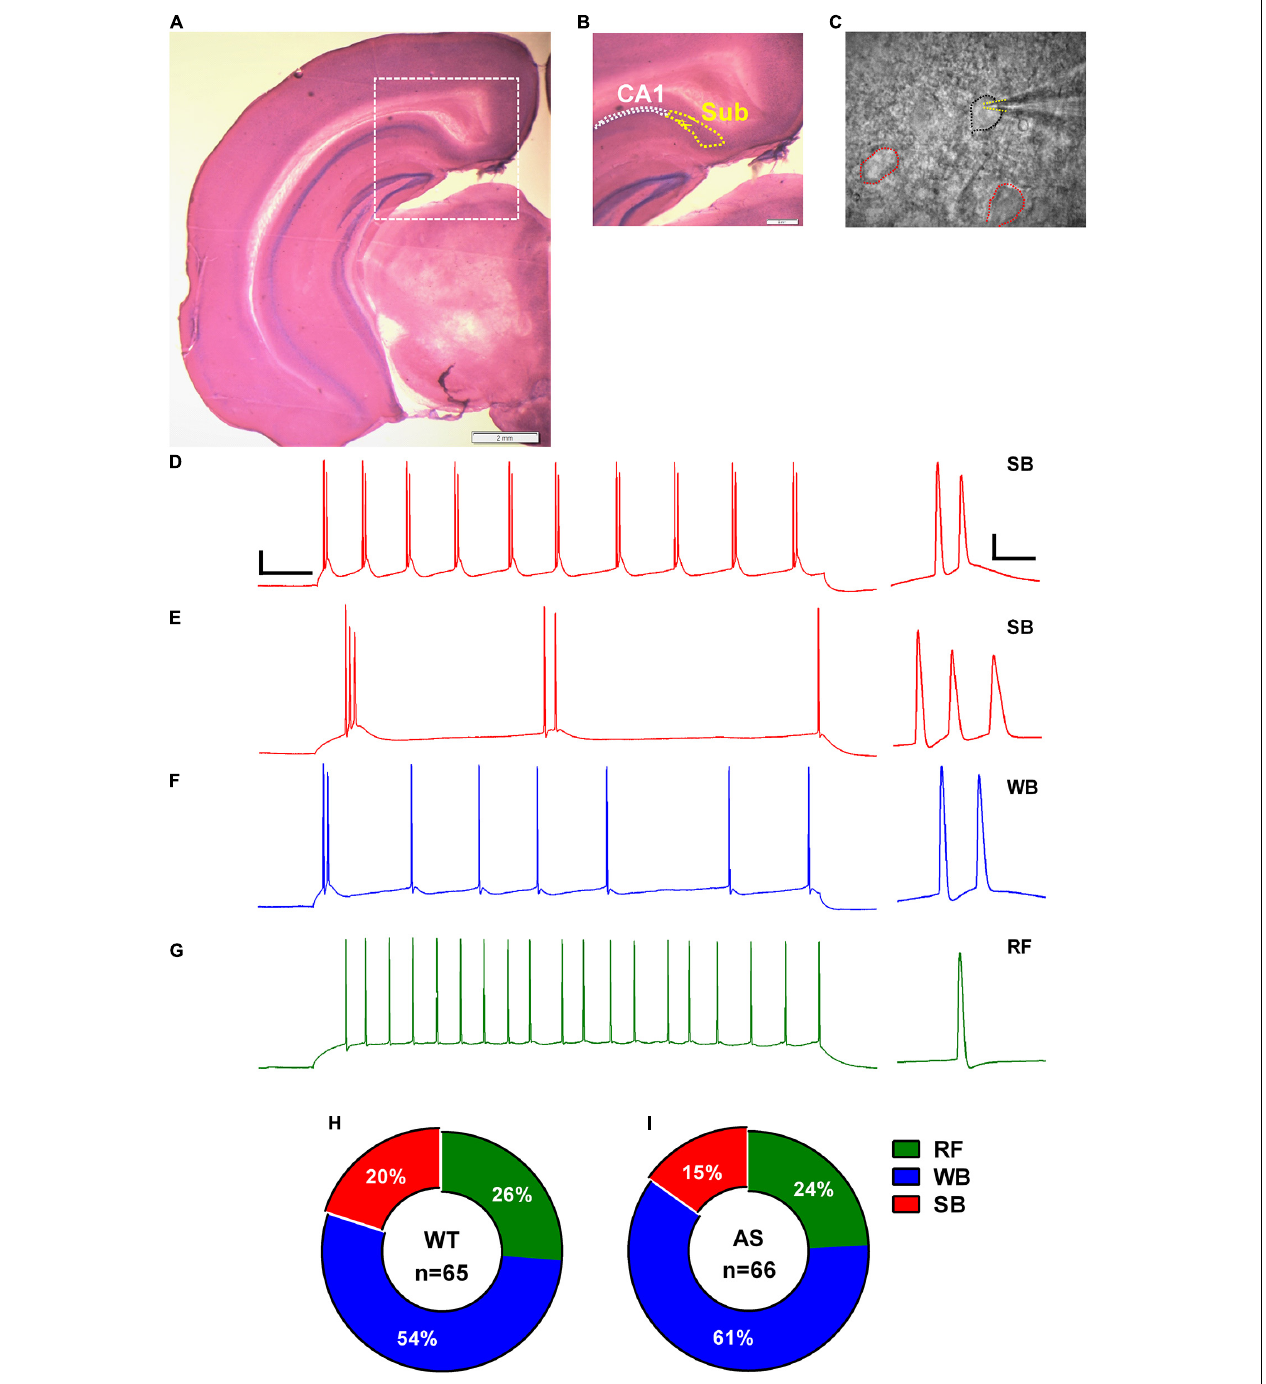
FIGURE 1 | Identification, classification, and distribution of subicular pyramidal neurons. (A) Nissl-stained coronal brain section after electrophysiological recording showing the different hippocampal regions. (B) Zoomed-in region from (A) (dashed white square) showing the hippocampal CA1 pyramidal layer demarcated with white dotted outline and the adjacent subicular region (Sub) defined with yellow dotted outline. (C) DIC image of the subicular region from (B) showing a patched pyramidal neuron (PN; black outline) and its neighboring cells (red outlines). Dashed yellow lines mark the patch pipette in whole-cell mode. Note that the pyramidal neurons (PNs) in subiculum are sparsely distributed. Scale: 2 mm. (E–G) Representative traces of various responses of subicular PNs to a 1-s somatic current injection revealed (D) strong bursting (SB) neurons with multiple ( > 3) bursts, (E) SB neurons with only 2–3 bursts, (F) weak bursting (WB) neurons with only one burst followed by a train of single spikes, and (G) regular firing (RF) neurons with trains of single action potentials (APs). Scale: 20 mV, 100 ms. Right: Expanded view of the first burst or AP from the corresponding trace. Scale: 20 mV, 10 ms. The APs in all the traces were obtained from WT mice elicited by a somatic